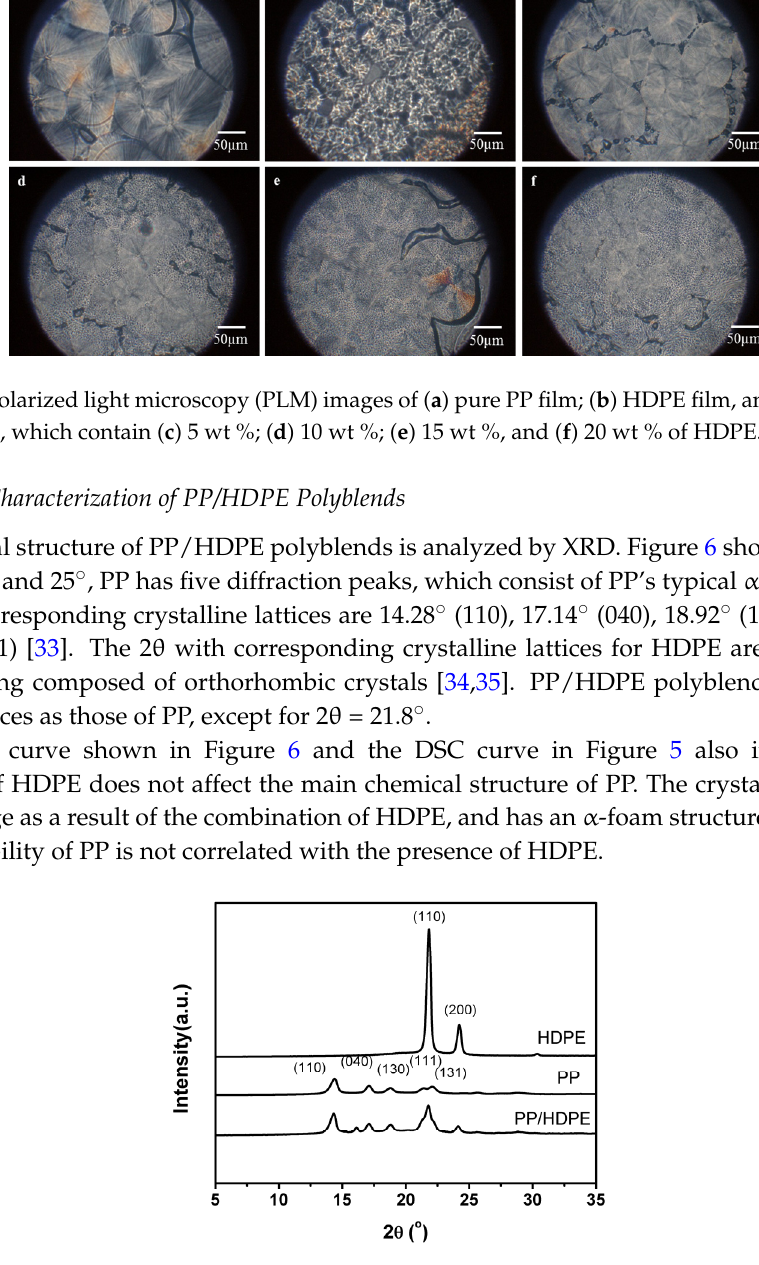
Table 2. Physical properties of the two polymers.